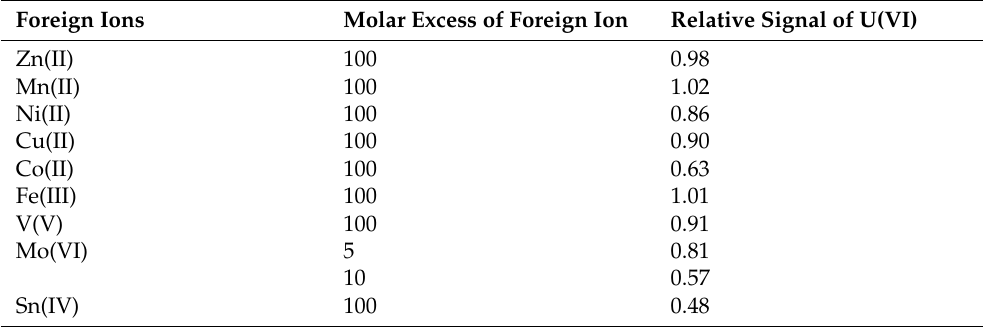
Table 3. Relative U(VI) signal after and before the addition of foreign ions. U(VI) concentration: 5 × 10 − 8 mol L − 1 . Accumulation time: 120 s.